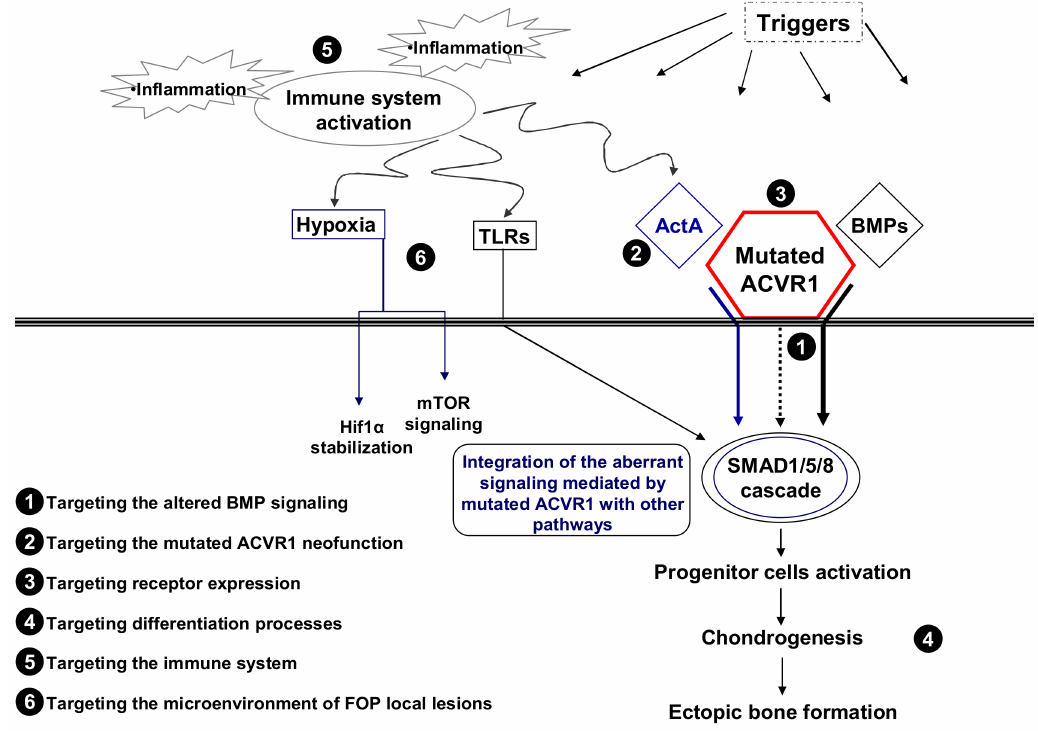
Figure 1. Schematic representation of molecular and cellular events involved in FOP pathogenesis. Druggable steps, some of which have recently been targeted to develop a treatment for the disease (see also Table 3), are indicated by numbers. TLRs, toll-like receptors; ActA, Activin A; BMPs, bone morphogenetic